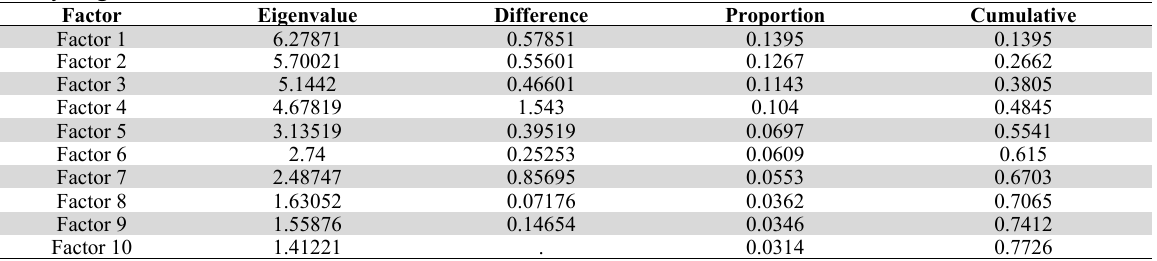
Analyse green investment factor Factor Eigenvalue Difference Proportion Cumulative Factor 1